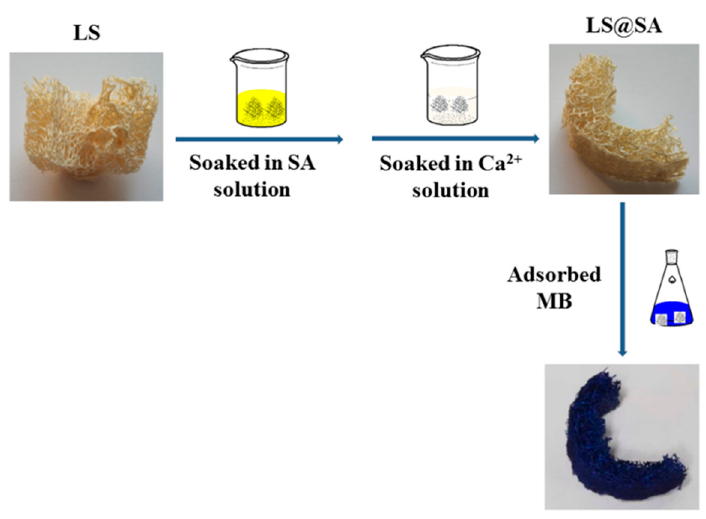
Figure 1. Schematic illustration of the forming mechanism of LS@SA composite.